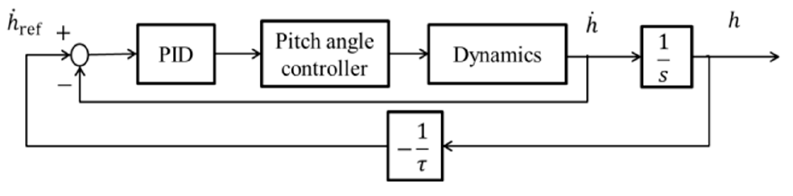
Figure 5. Flare control system.